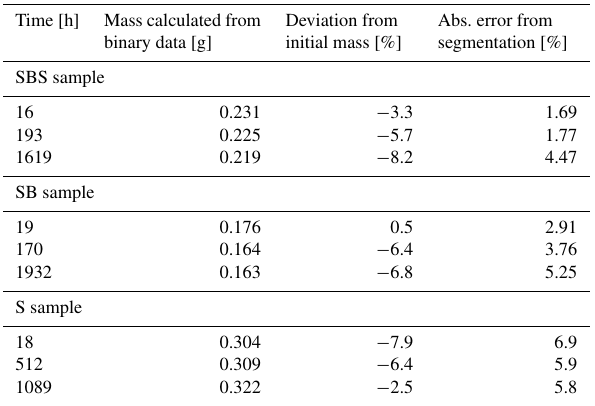
Table 4. Salt content of the samples derived from image analysis and compared to the initial weight by mass